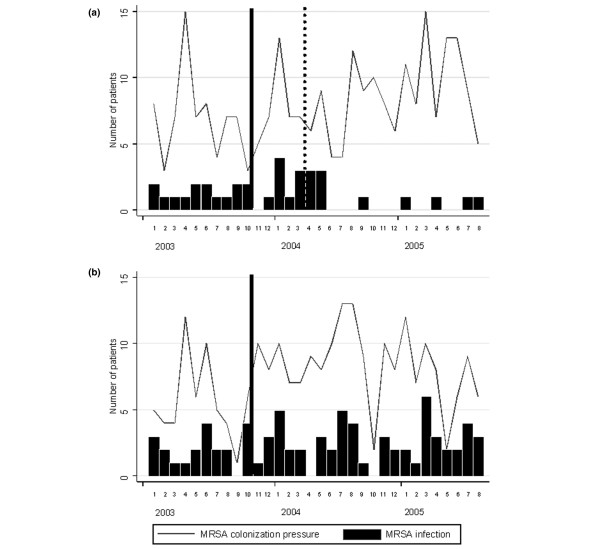
Previously known MRSA carriage on admission versus ICU-acquired MRSA infection. Shown are the numbers of patients with previously known MRSA carriage on admission (MRSA colonization pressure) and the numbers of patients with ICU-acquired MRSA infections (surgical and medical ICUs; Geneva University Hospitals; January 2003 through August 2005). (a) (upper panel) Medical ICU. The vertical line on the figure indicates the initiation of rapid on-admission screening in November 2003 (phase II). The dashed vertical line indicates the initiation of pre-emptive isolation for all patients in April 2004 (phase III). (b) (lower panel) Surgical ICU. The vertical line on the figure indicates the initiation of rapid MRSA screening on admission and extension of pre-emptive isolation in November 2003 (phase II). ICU, intensive care unit; MRSA, methicillin-resistant Staphylococcus aureus.